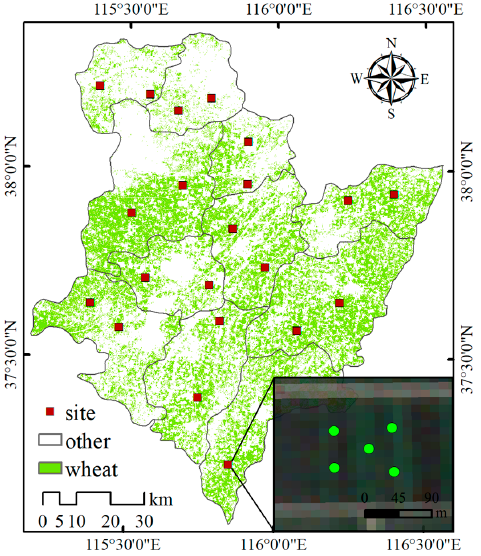
Figure 1. Experiment locations.